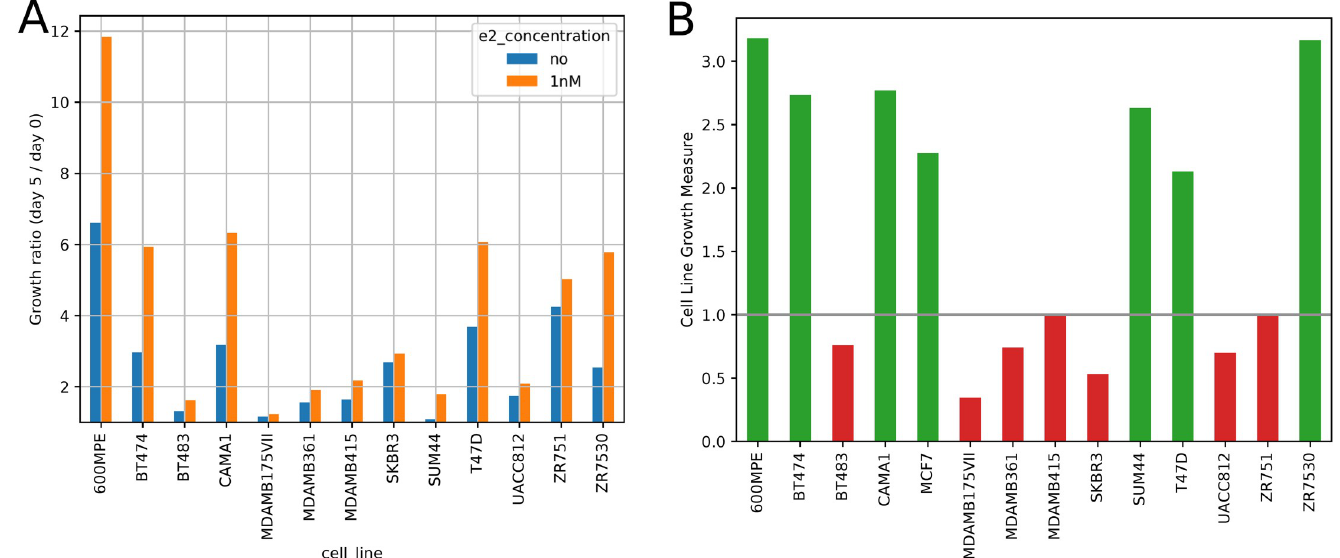
Fig 3. Cell line growth data. (a) shows cell line growth ratios (day 5 cell count / day 0 cell count), with and without 1nM serum estrogen. (b) shows the cell line growth measure defined in Eq 6. Threshold 1.0 was used to denote cell lines as responsive (green) or non-responsive (red).